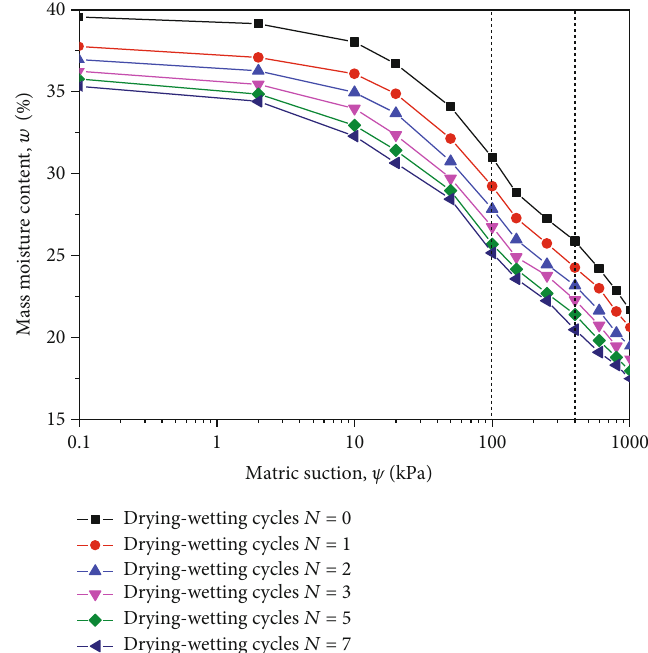
Figure 2: SWCC of residual soil under di ff erent drying – wetting cycle